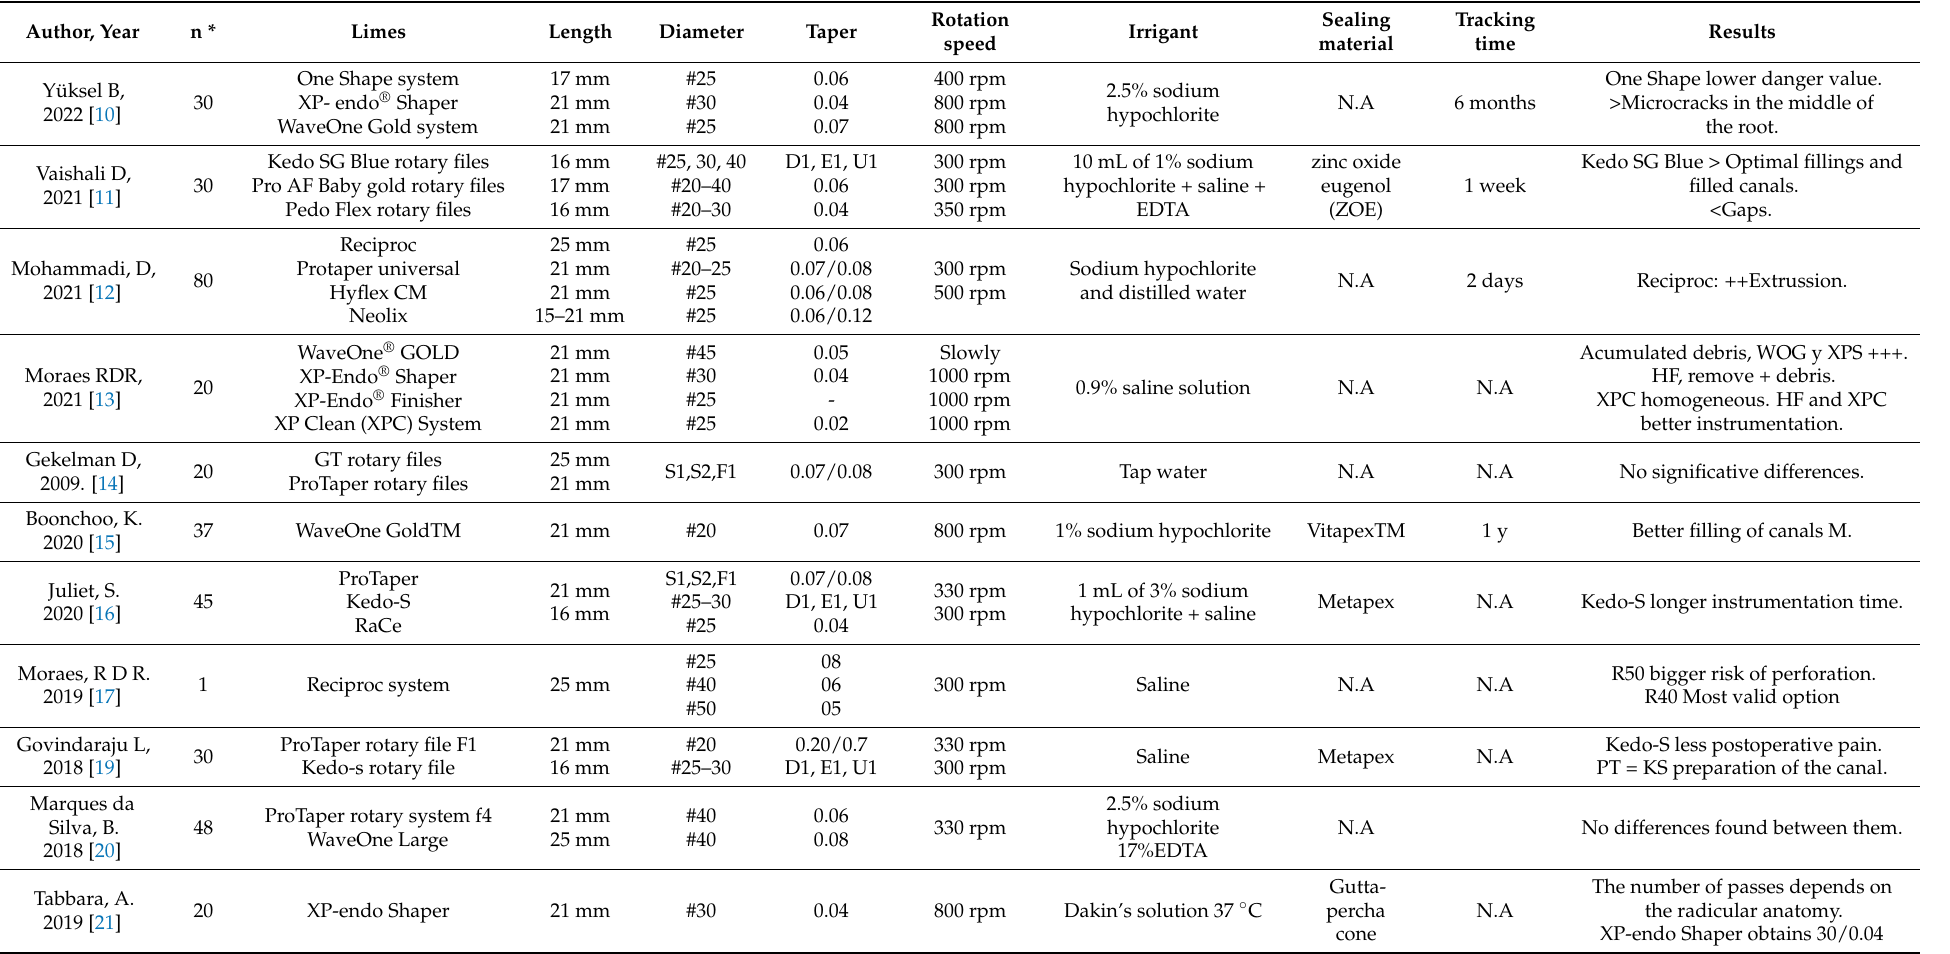
Table 1. List of the characteristics of the different current rotary systems for root canal treatment in temporary